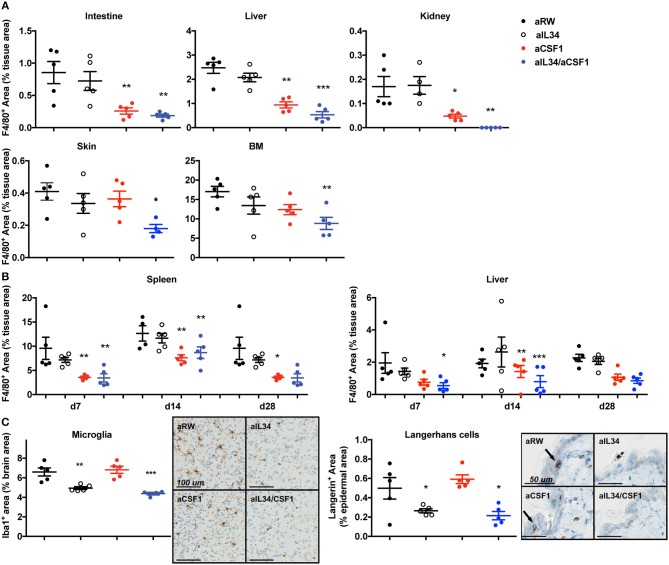
CSF1 and IL34 regulate macrophage homeostasis in adult mice. (A) Effect of aCSF1 and/or IL34 antagonist antibodies on tissue-resident macrophages. C57/BL6 mice were treated with aCSF1 and/or aIL34, or anti-ragweed (aRW) IgG2a intraperitoneally for 1 month. Formalin-fixed tissues (intestine, liver, kidney, skin, and bone marrow) were stained with F4/80 and stained area was plotted and percentage of total tissue area to quantitate tissue-resident macrophages. (B) Quantitation of tissue-resident macrophages in spleen and liver after 7, 14, and 28 days of aCSF1 and/or aIL34 treatment stained with F4/80. (C) Staining of tissue-resident brain microglia (stained with anti-Iba-1) or skin epidermal Langerhans cells (anti-Langerin). Immuno-reactive cells were quantitated by digital image analysis as described in Materials and Methods. Results are displayed as group means ± SEM (standard error of the mean), and are representative of at least two independent experiments. *p < 0.05, **p < 0.01, ***p < 0.001.